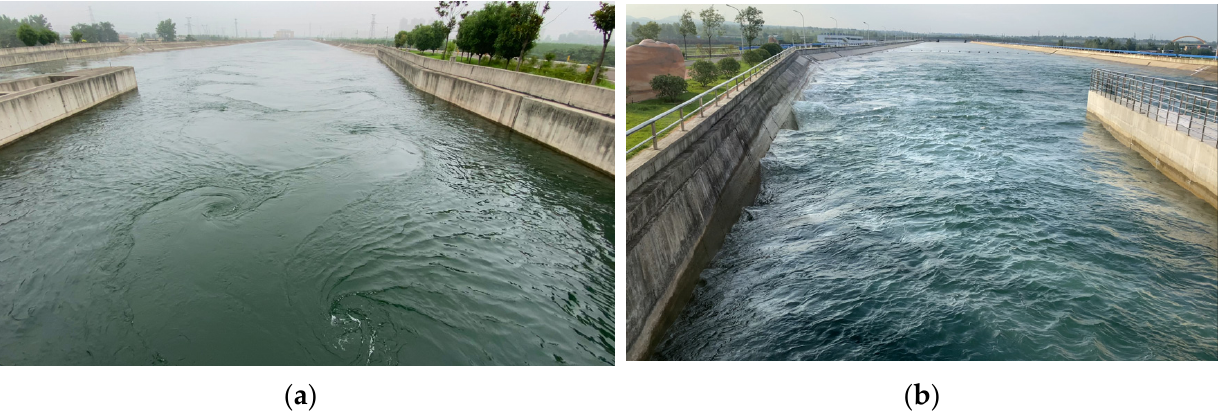
Figure 9. Flow regime at the outlet: ( a ) the aqueduct of the tributary of the Shuangji River and ( b ) the aqueduct of the Lihe River.